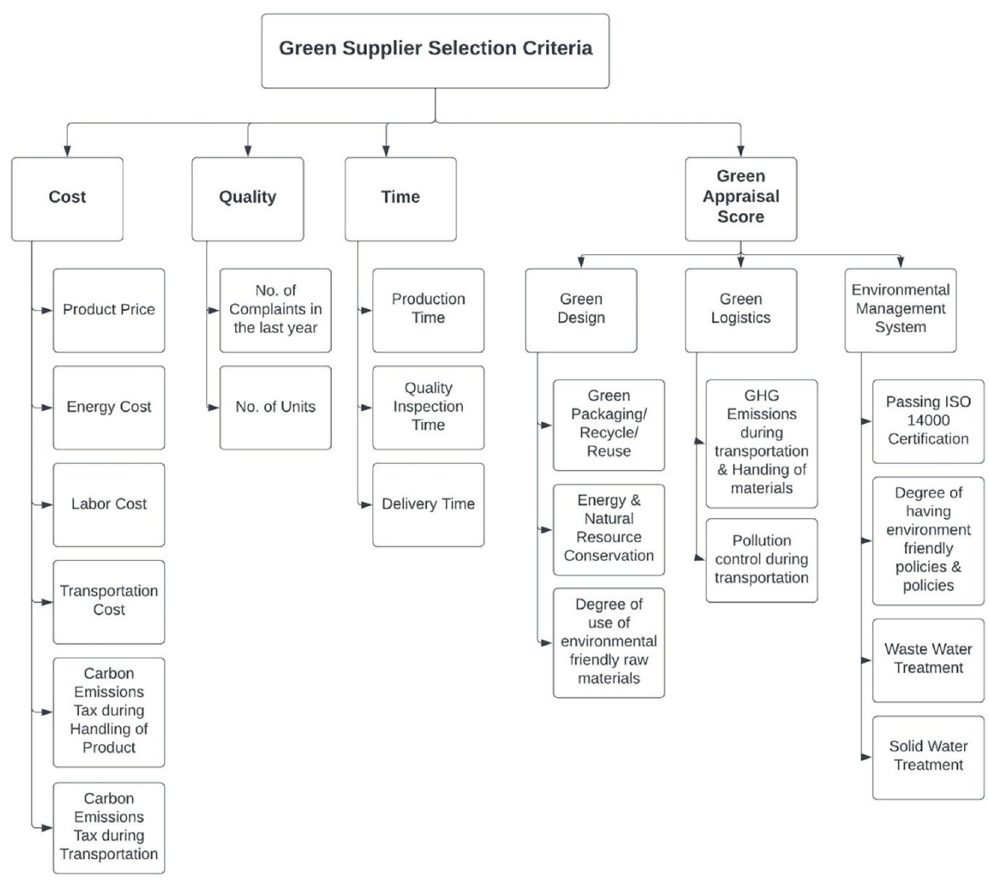
Fig 1. Green supplier selection